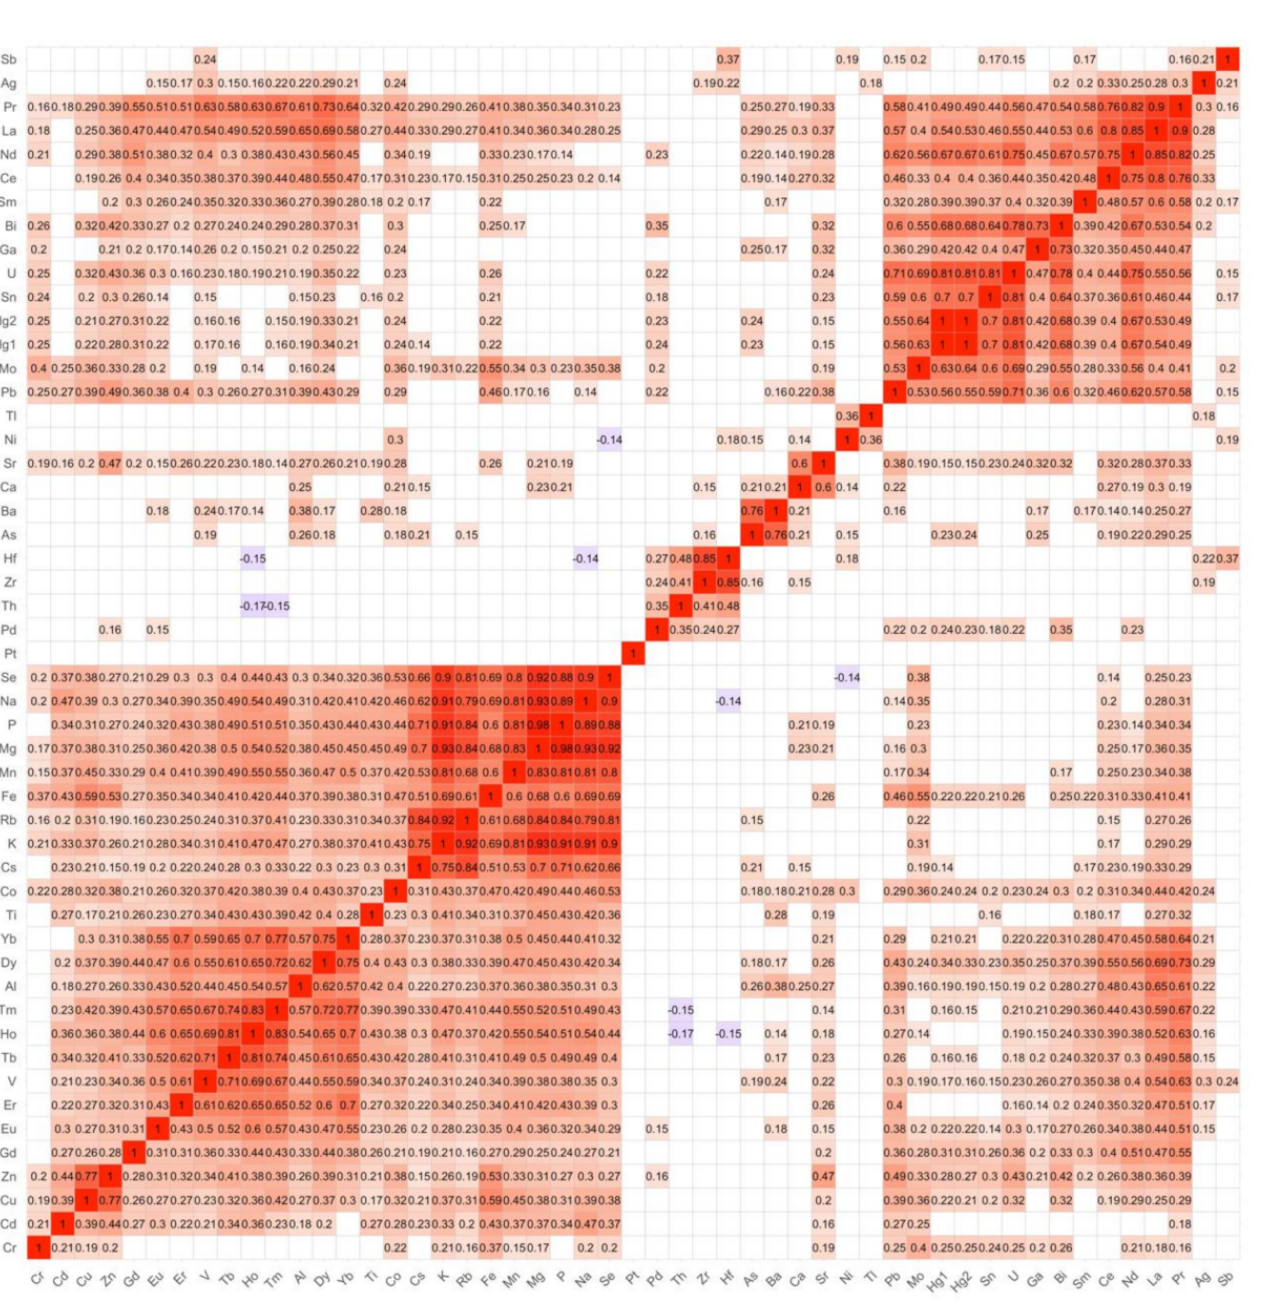
Figure 2. Spearman rank-order correlation matrix for studied